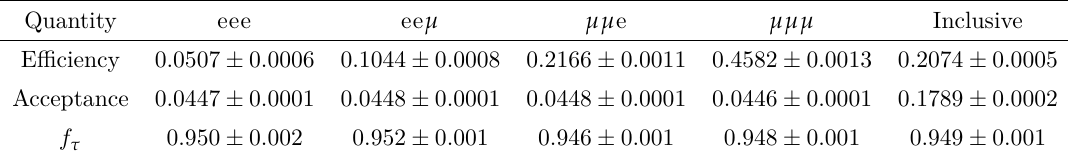
Table 4 . Efficiencies, acceptances, and proportion of fiducial signal events in the SR for the combined selection and each of the considered flavour channels separately, as determined using the powheg WZ MC sample. Uncertainties are statistical only. Note that while the fiducial region is defined separately per flavour, and thus the inclusive efficiency is a weighted average of the per channel ones, the TR is always flavour-inclusive: the inclusive acceptance is therefore by definition the sum of the ones split by